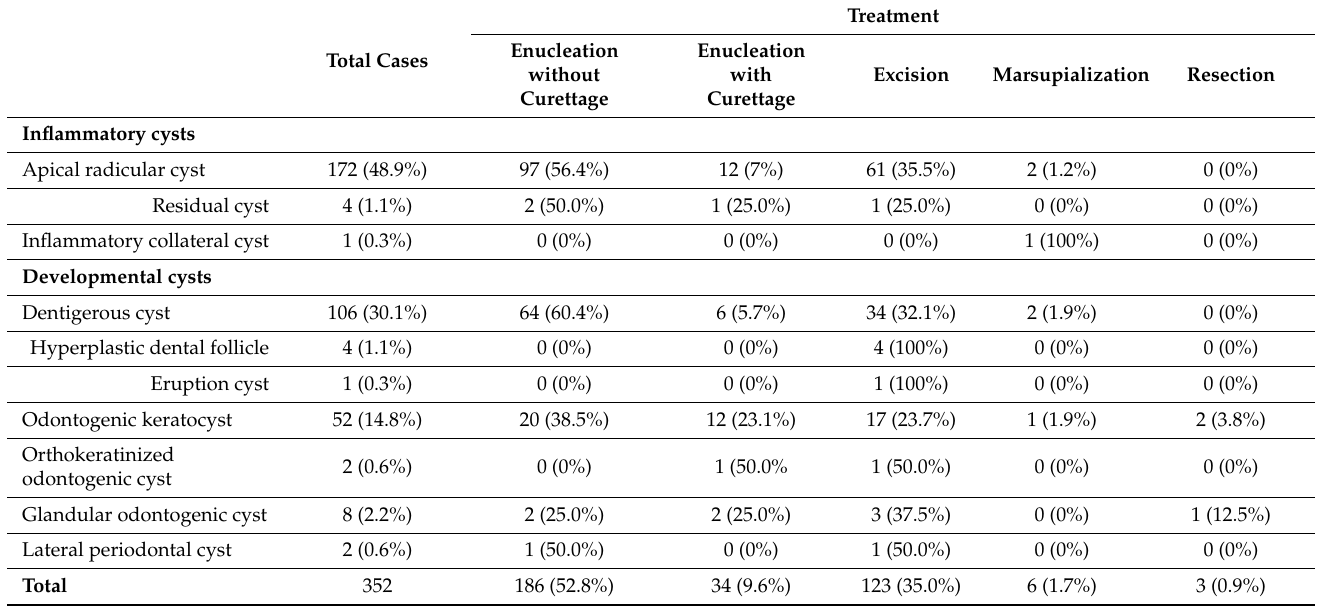
Table 5. Summary of the treatment modalities of each odontogenic cyst.